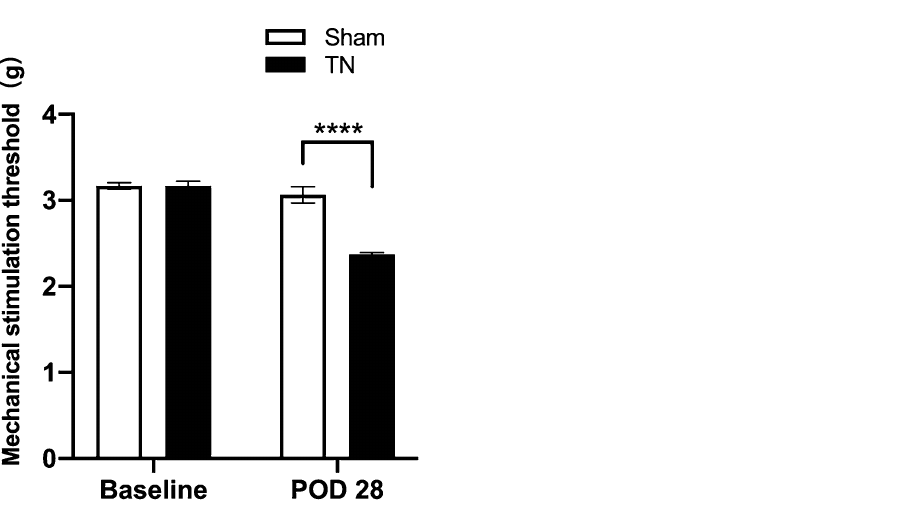
Figure 1. Orofacial mechanical stimulation threshold changes in the TN rat model. There was no significant difference in the hyperalgesia threshold of the right orofacial mechanical stimulation between the TN group and the sham group (n = 4 for each group) before surgery. On the 28th day after the operation, the mechanical stimulation threshold in the sham group returned to the preoperative baseline threshold, while the mechanical stimulation threshold of rats in the TN group was significantly lower than that of the sham group and at baseline. **** p < 0.0001 as determined by two-way ANOVA with Sidak’s multiple comparisons tests. All data show the mean ±